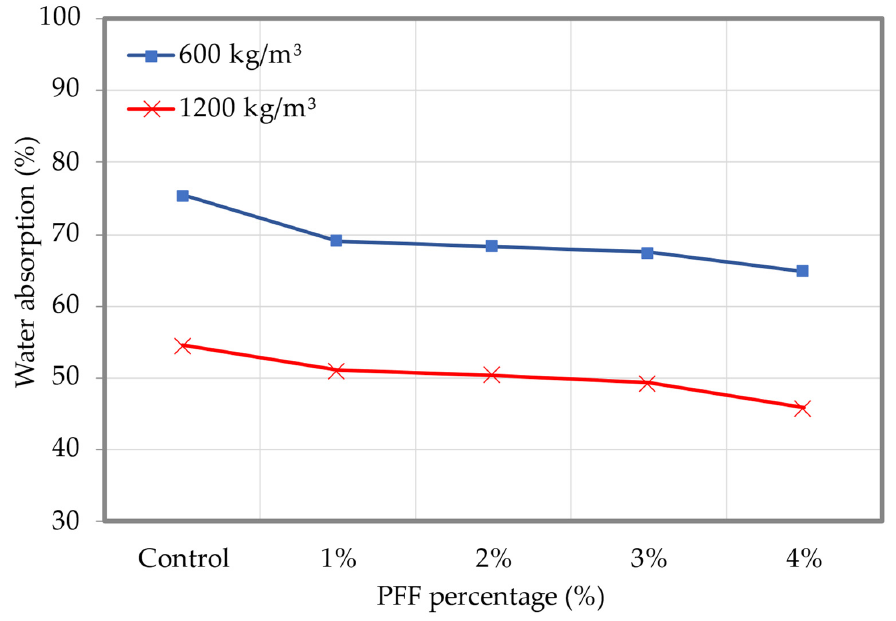
Figure 12. Water absorption of foamed concrete with varying percentages of PFF.